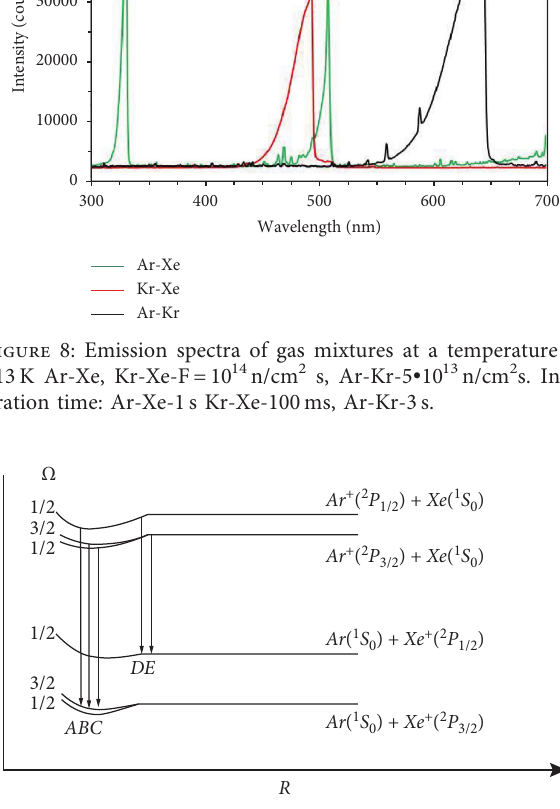
Figure 9: Illustrative diagram of potential curves of a (ArXe) + molecule.